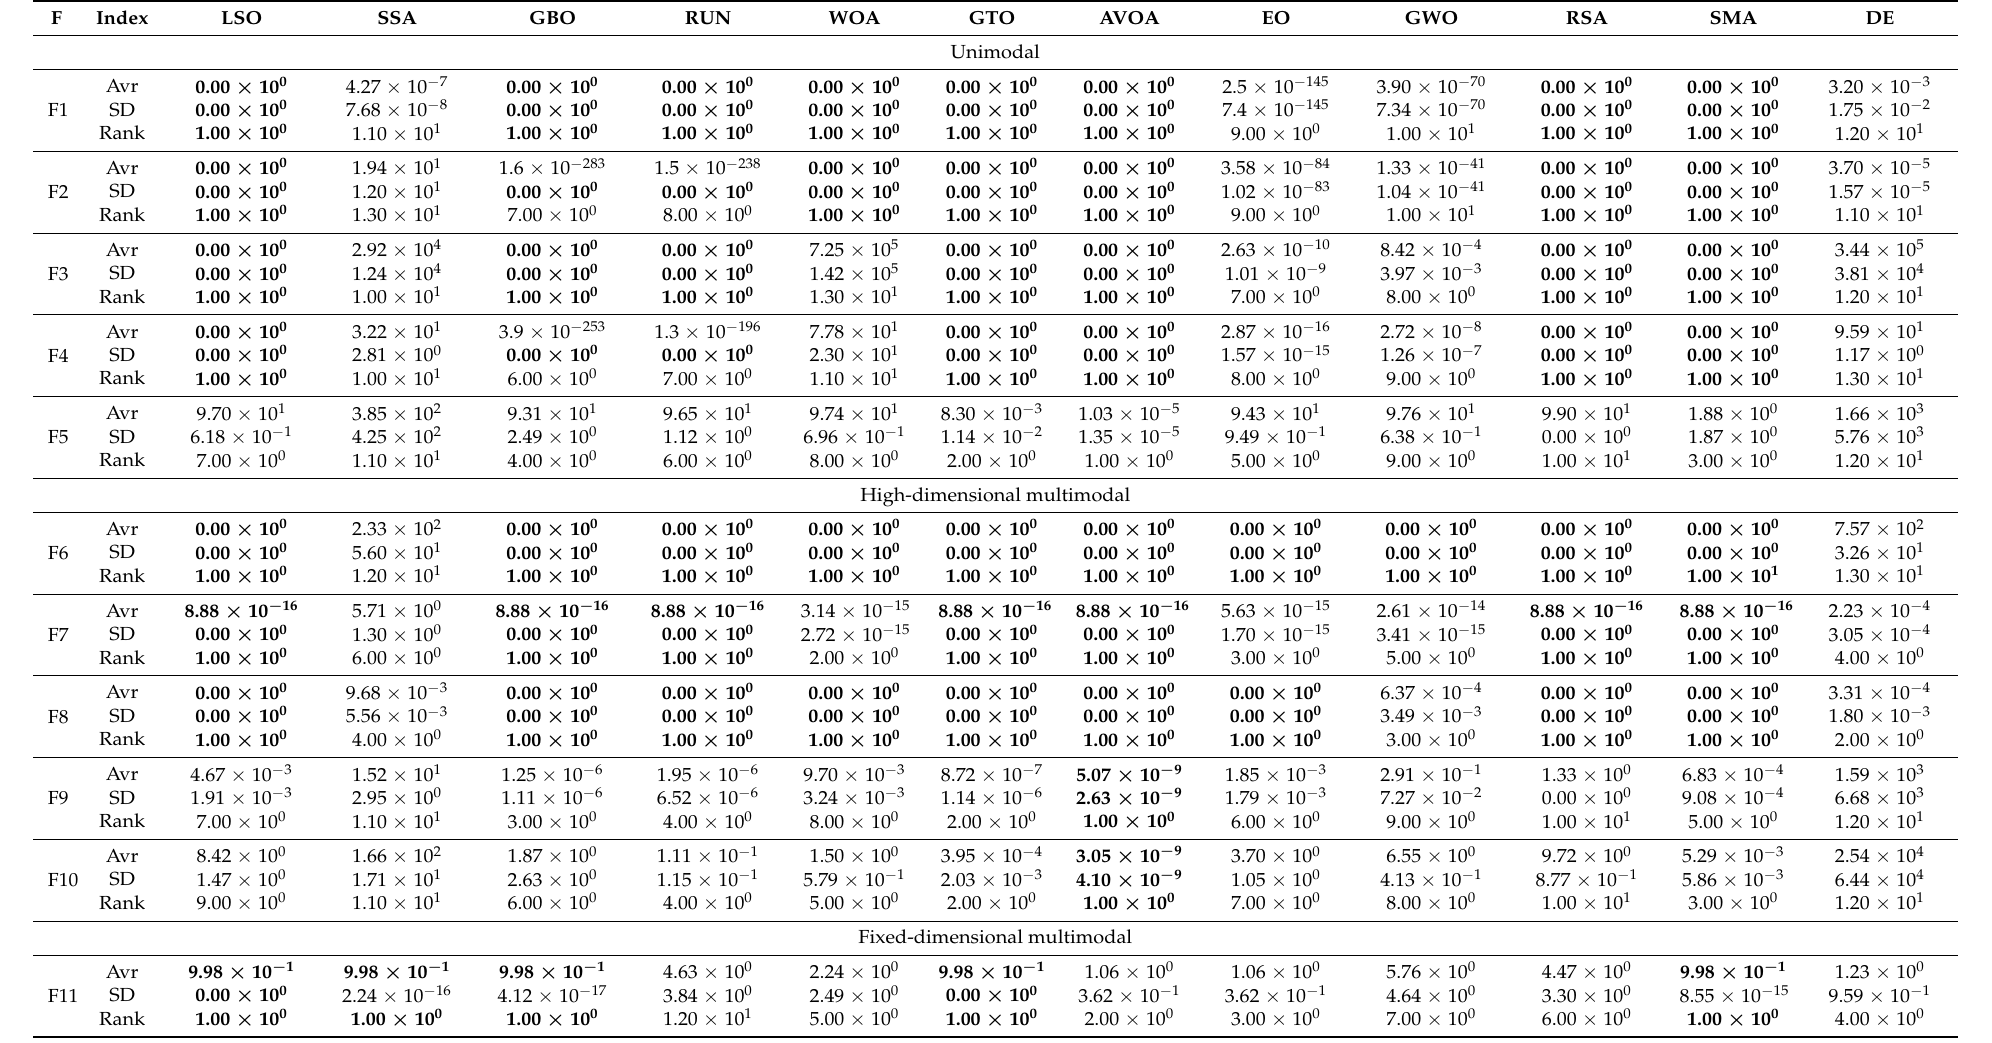
Table 6. Avr and SD of CEC2005 for 25 independent runs (The bolded value is the best